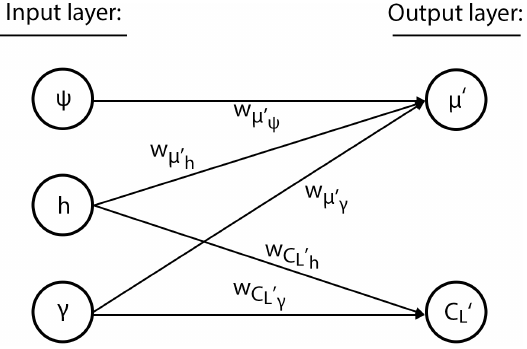
Figure 7. Topology of the dynamic soaring albatross neurocontroller. The bias nodes b and b µ (cid:48) , as well as the connection weights w take the values: C L (cid:48) = b C L (cid:48)